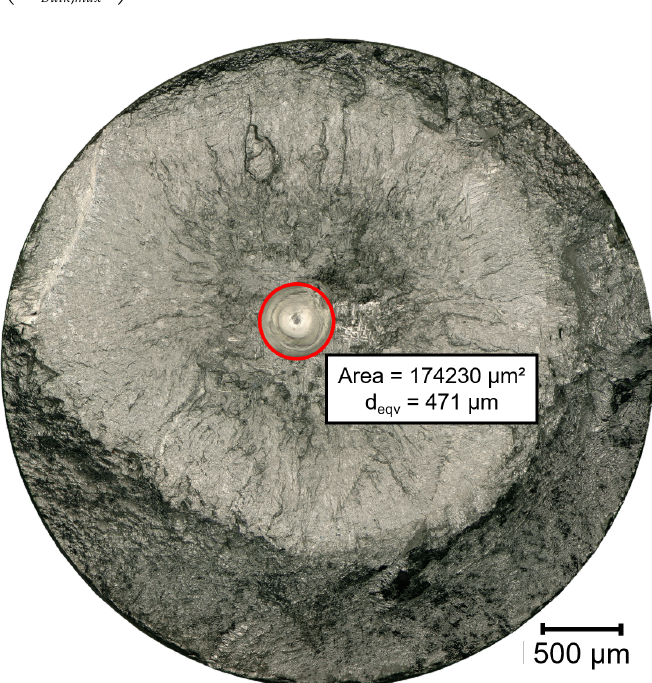
Figure 6. Gas pore within bulk material as representative inner